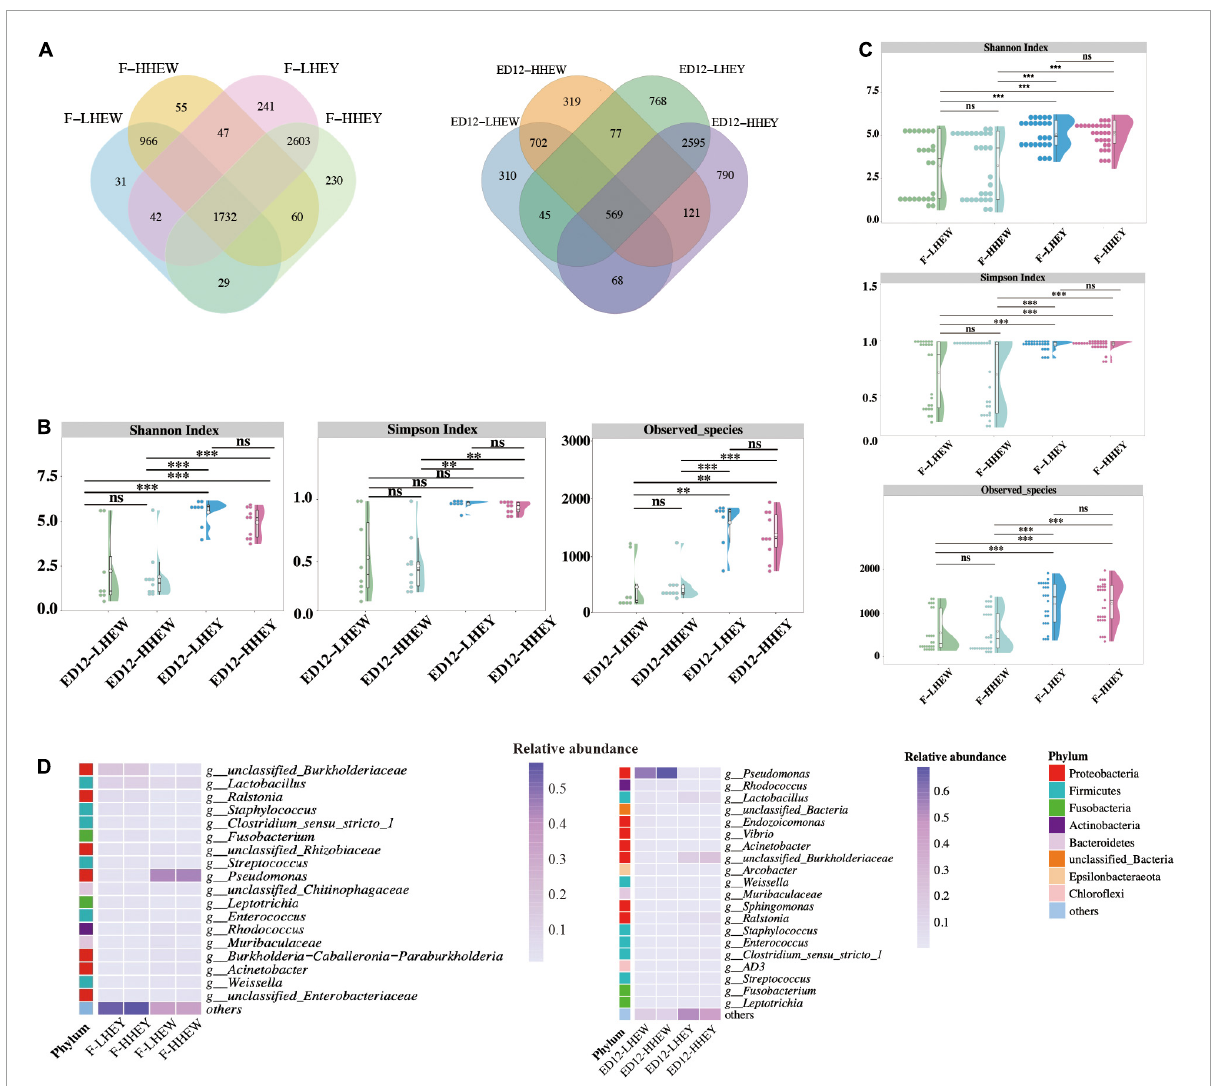
FIGURE6 Microbial composition and diversity in egg white and yolk of low and high hatchability groups. (A) Overlap analysis of the shared amplicon sequence variants (ASVs) in high and low hatchability groups of egg yolk and white in fresh eggs and eggs for 12 days of incubation. (B) Alpha diversity (Shannon, Simpson, and Observed species) of F-LHEY, F-HHEY, F-LHEW, and F-HHEW. (C) Alpha diversity (Shannon, Simpson, and Observed species) of ED12-LHEY, ED12-HHEY, ED12-LHEW, and ED12-HHEW. (D) The heat map shows the results of the top 19 relative abundance of genera and 21 relative abundance of genera in four groups of fresh eggs and eggs at 12 embryonic ages. The 19 and 21 genera were obtained by collecting the top 10 relatively abundant genera that did not overlap in four groups at the same period. * P < 0.05, *** P < 0.001, and ns means no